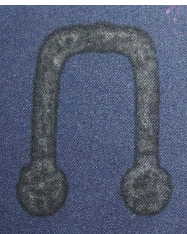
Figure 6. Print result when using the print parameters determined by the experimental